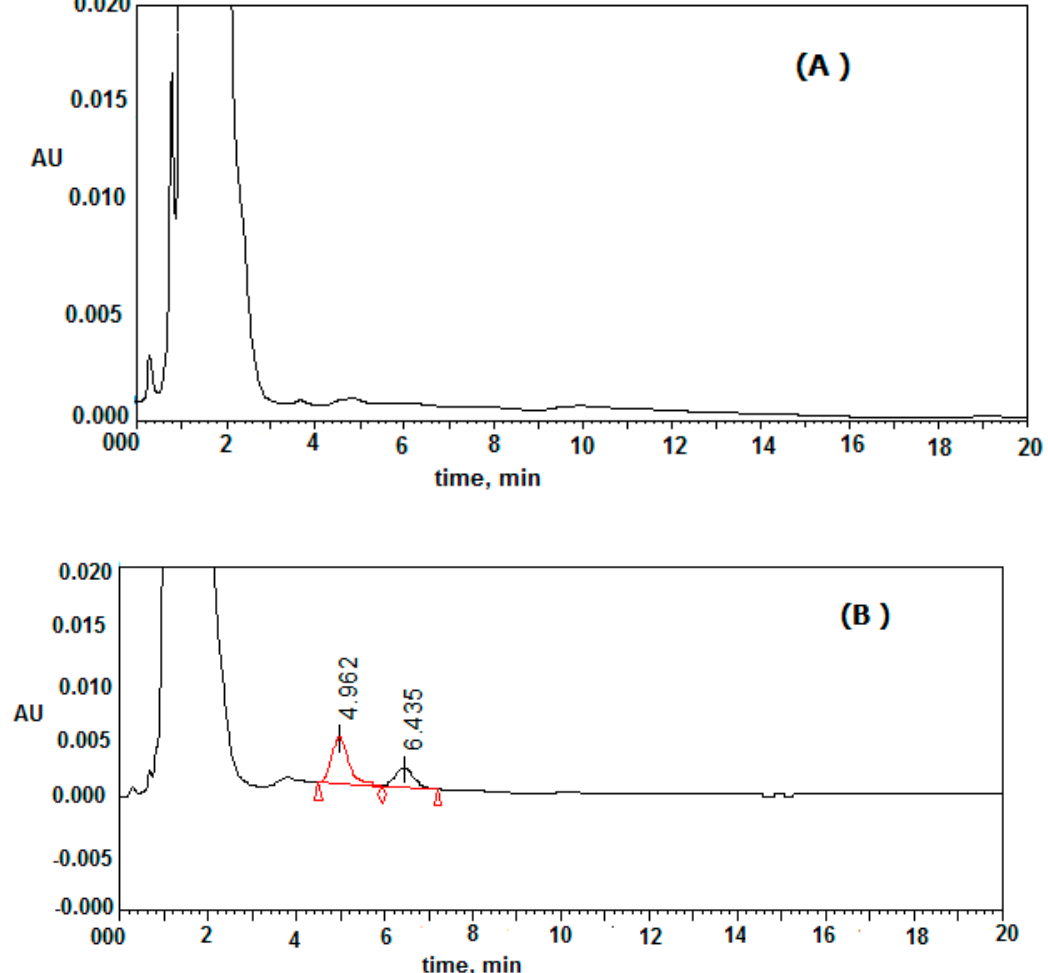
Figure 4. HPLC chromatograms of mouse plasma sample after 3 h from administration ( B ) and ( A ) bank mouse plasma.